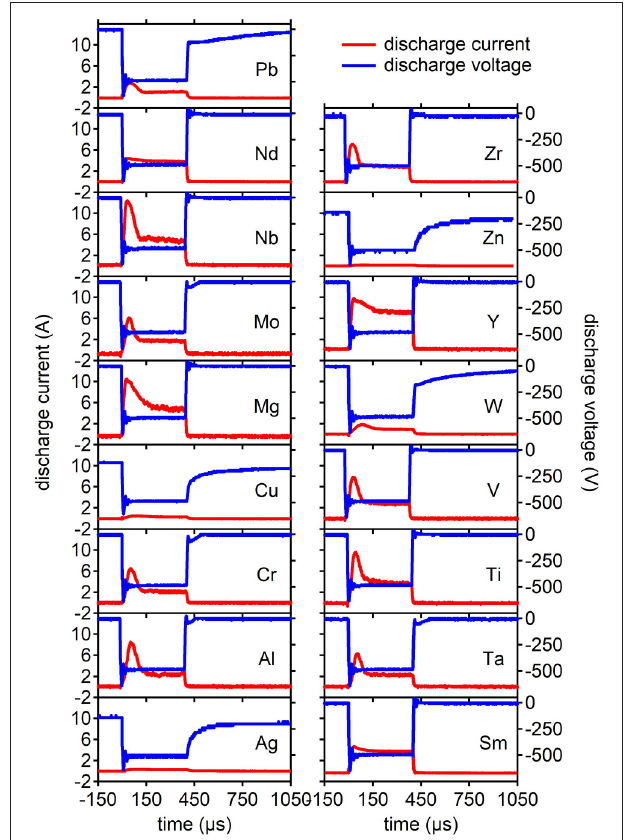
FIGURE 3 | The current and voltage pulse measured for 17 different metals. The argon pressure was fixed at 1.8 Pa. A 500 V rectangular pulse was applied for 400 µ s. The duty cycle was set equal to